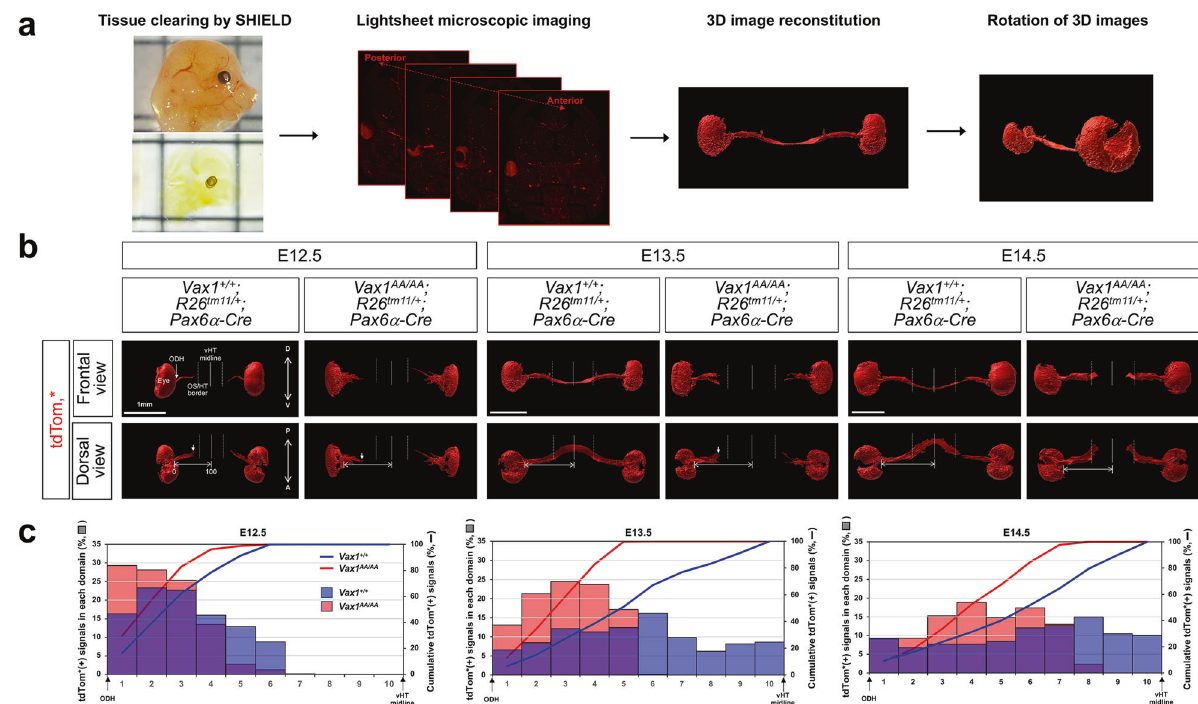
Fig. 4 Retarded RGC axon growth in Vax1 AA/AA mice. a Schematic diagram depicting the 3D reconstitution of tdTom* fl uorescent signals in RGC axons. Retinal cells, including RGCs, in Vax1 + / + and Vax1 AA/AA littermate mouse embryos, which were cleared by the SHIELD method, were visualized by the tdTom* reporter expressed in the R26 tm11 gene locus in a Pax6 α -Cre-dependent manner. The tdTom* signals of retinal cells and RGC axons, which grow in the OS to form the OC prior to extending through the OT, were then reconstituted in 3D (see details in Methods). b The 3D reconstituted images of E12.5, E13.5, and E14.5 mouse embryos are shown. c Relative tdTom* intensities in each domain of the RGC axon track, which is divided into 10 segments from the optic nerve head (OHD) to the vHT midline, are shown in the graphs. Cumulative tdTom* intensities, which represent the positions of RGC axon terminals, are also shown in the graphs. The values are averages ( n = 3; 3 independent